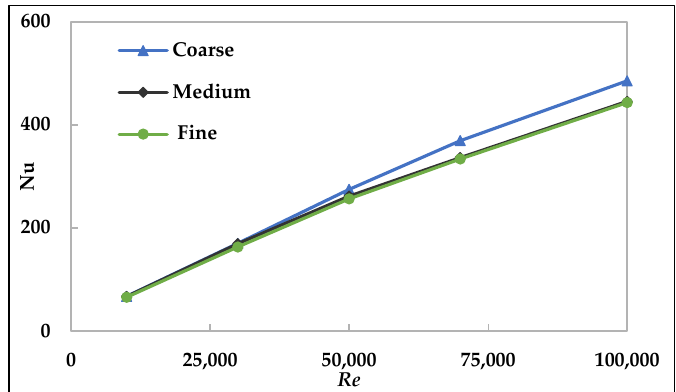
Figure 3. Mesh independence study for three different grids used in the present study.